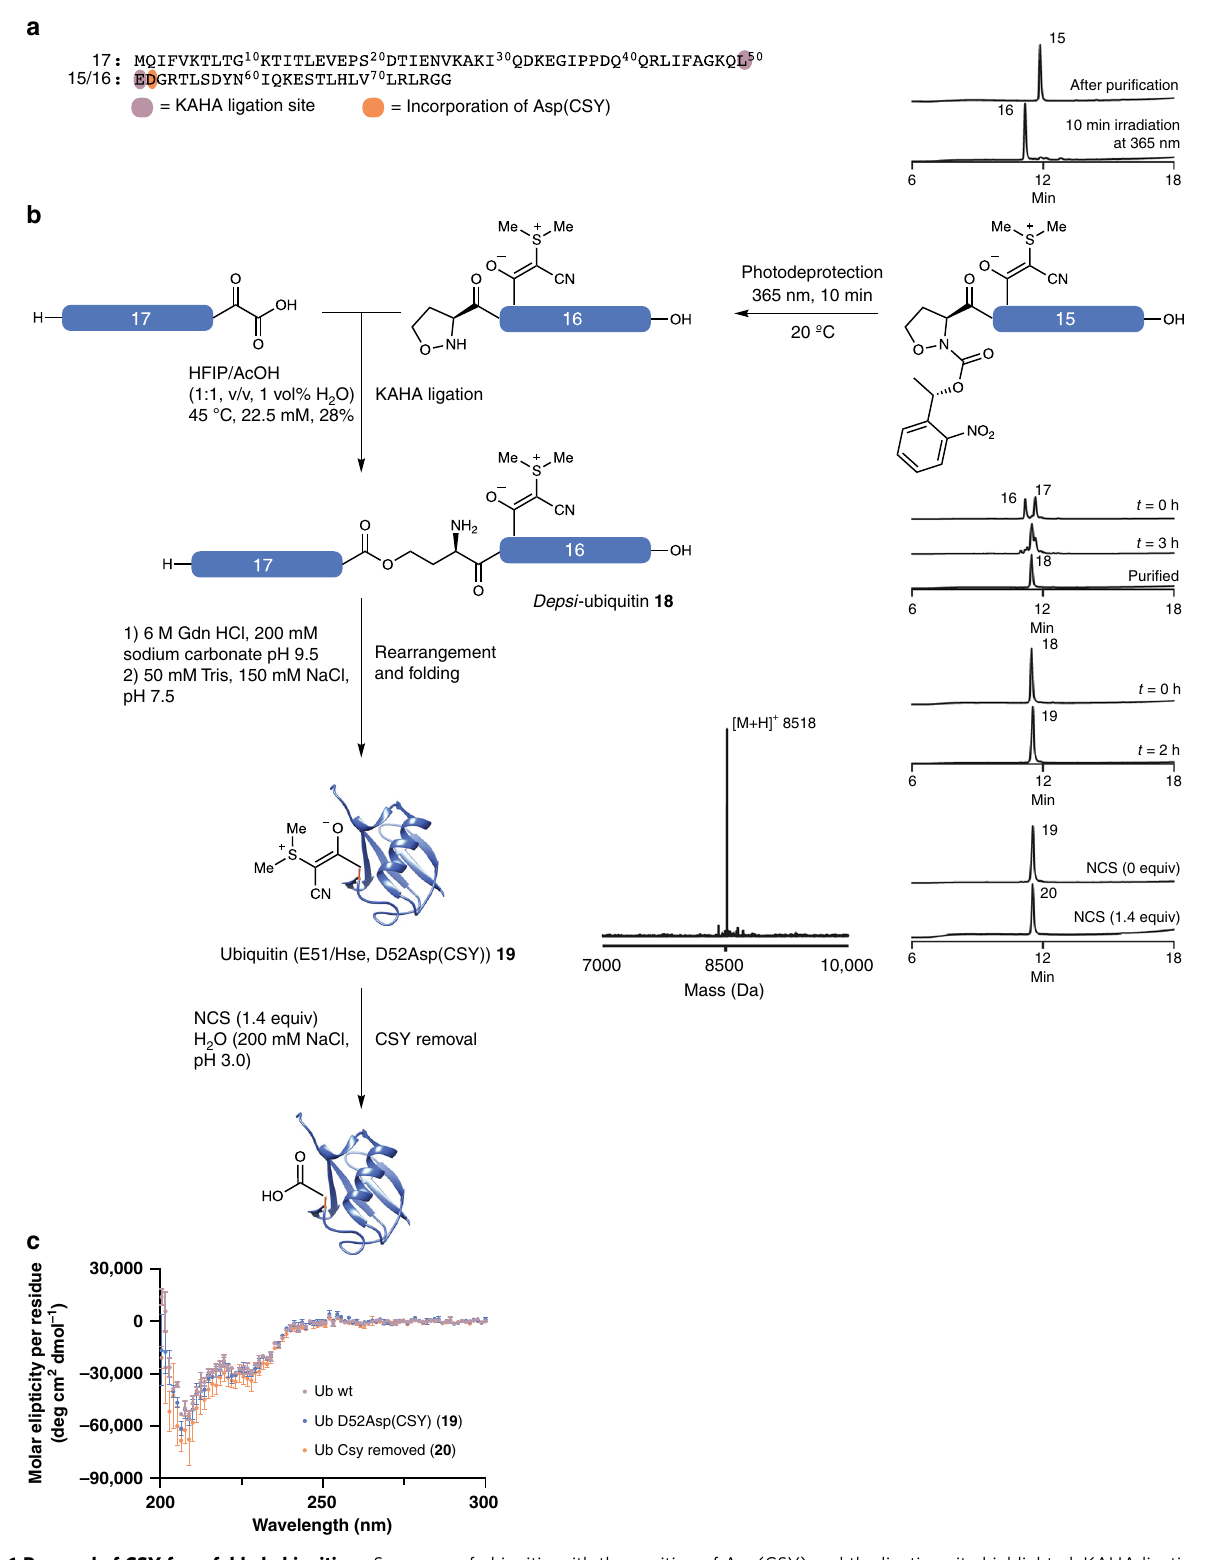
Fig. 6 Removal of CSY from folded ubiquitin. a Sequence of ubiquitin with the position of Asp(CSY) and the ligation site highlighted. KAHA ligation was carried out using 16 and 17. b Synthesis of ubiquitin (E51Hse/D52Asp(CSY)) 19 and chemoselective removal of CSY on folded ubiquitin(E51Hse/Asp52Asp (CSY)) 19 in acidic saline. c CD spectra con fi rm that the ubiquitin-fold remains with CSY and after CSY removal. Data are shown as the mean of three independent measurements with ±SD. Recombinant ubiquitin is shown for comparison. Ubiquitin structure was reproduced from 5DFL 41